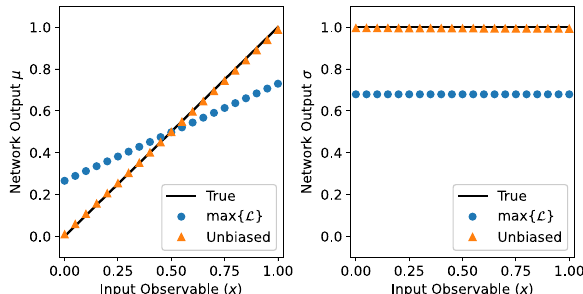
Fig. 5 Parameters of the posterior density functions predicted by the MDNs of Sect. 5.2 for various values of the input x . Without correction, the network will underestimate the width of the posterior density, and predict a maximum-likelihood θ value biased towards the middle of the sampled rang